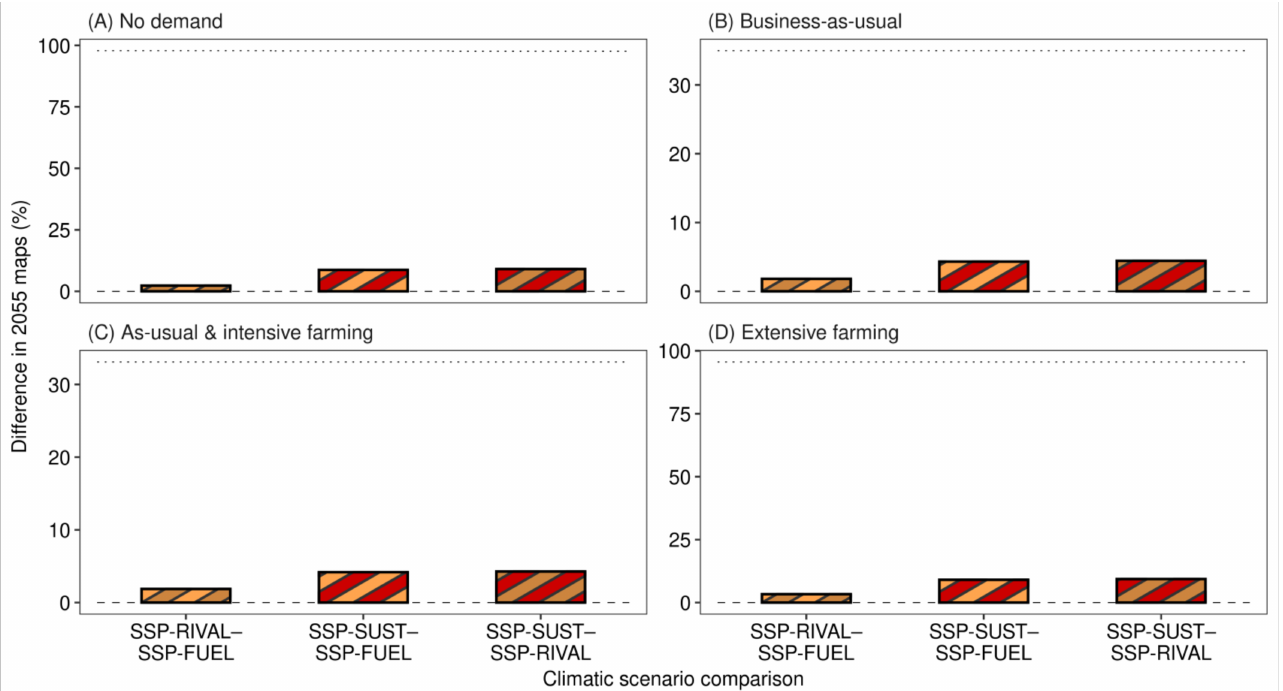
Figure 5. Percent of the map cells that had different LUC in two predicted maps of 2055 under two climatic scenarios, and for any of the following four scenarios of demand in 2015–2055 LUC transitions: ( A ) no pre-specified demand; ( B ) business-as-usual pre-specified demand; ( C ) as-usual, but with the 2015 intensive farming preserved; and ( D ) inverse transitioning to 1970, which had characteristics of extensive farming. The three climatic scenarios were the SSP-SUST, SSP-RIVAL and SSP-FUEL, from the more to the less optimistic one. The horizontal dashed and dotted lines indicate the respective lower and upper bounds which are the theoretically least and greatest differences that the two compared maps can have for the occurred 2015–2055 LUC transitions of the specific demand